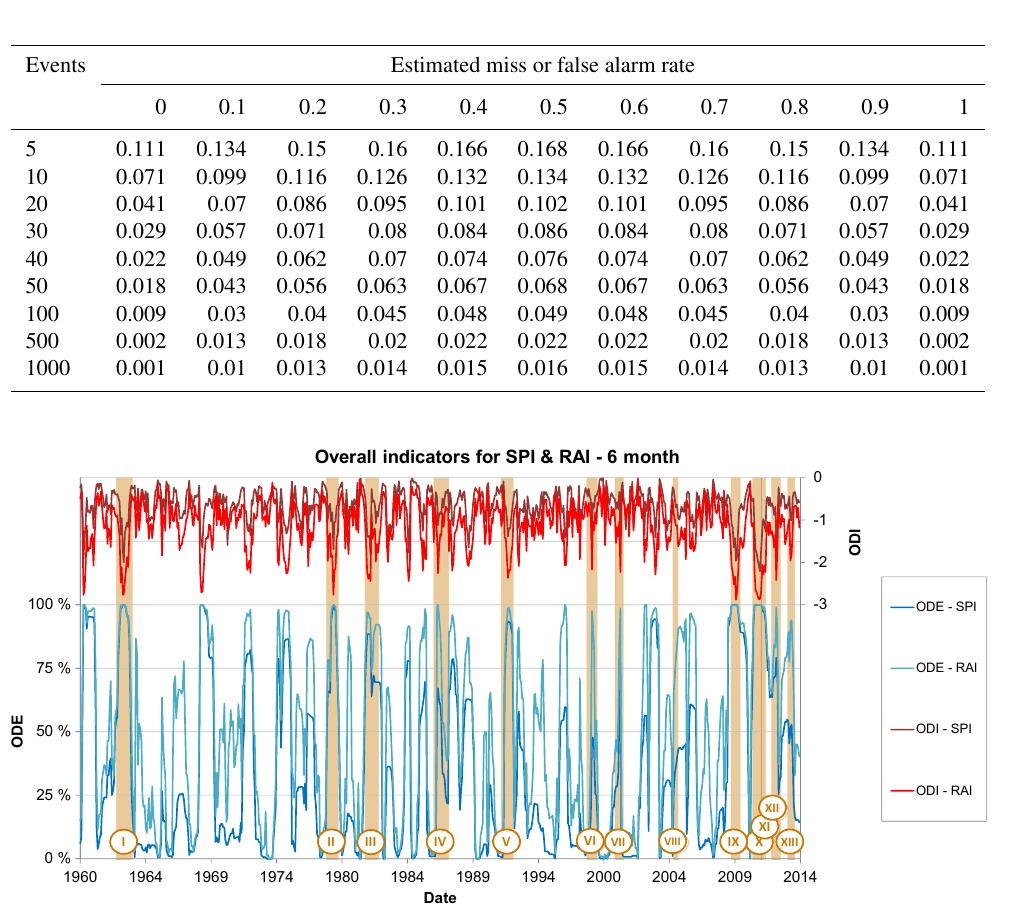
Figure 4. ODE and ODI values using the 6-month timescales of SPI and RAI indices, compared with the 13 detected historical droughts (in